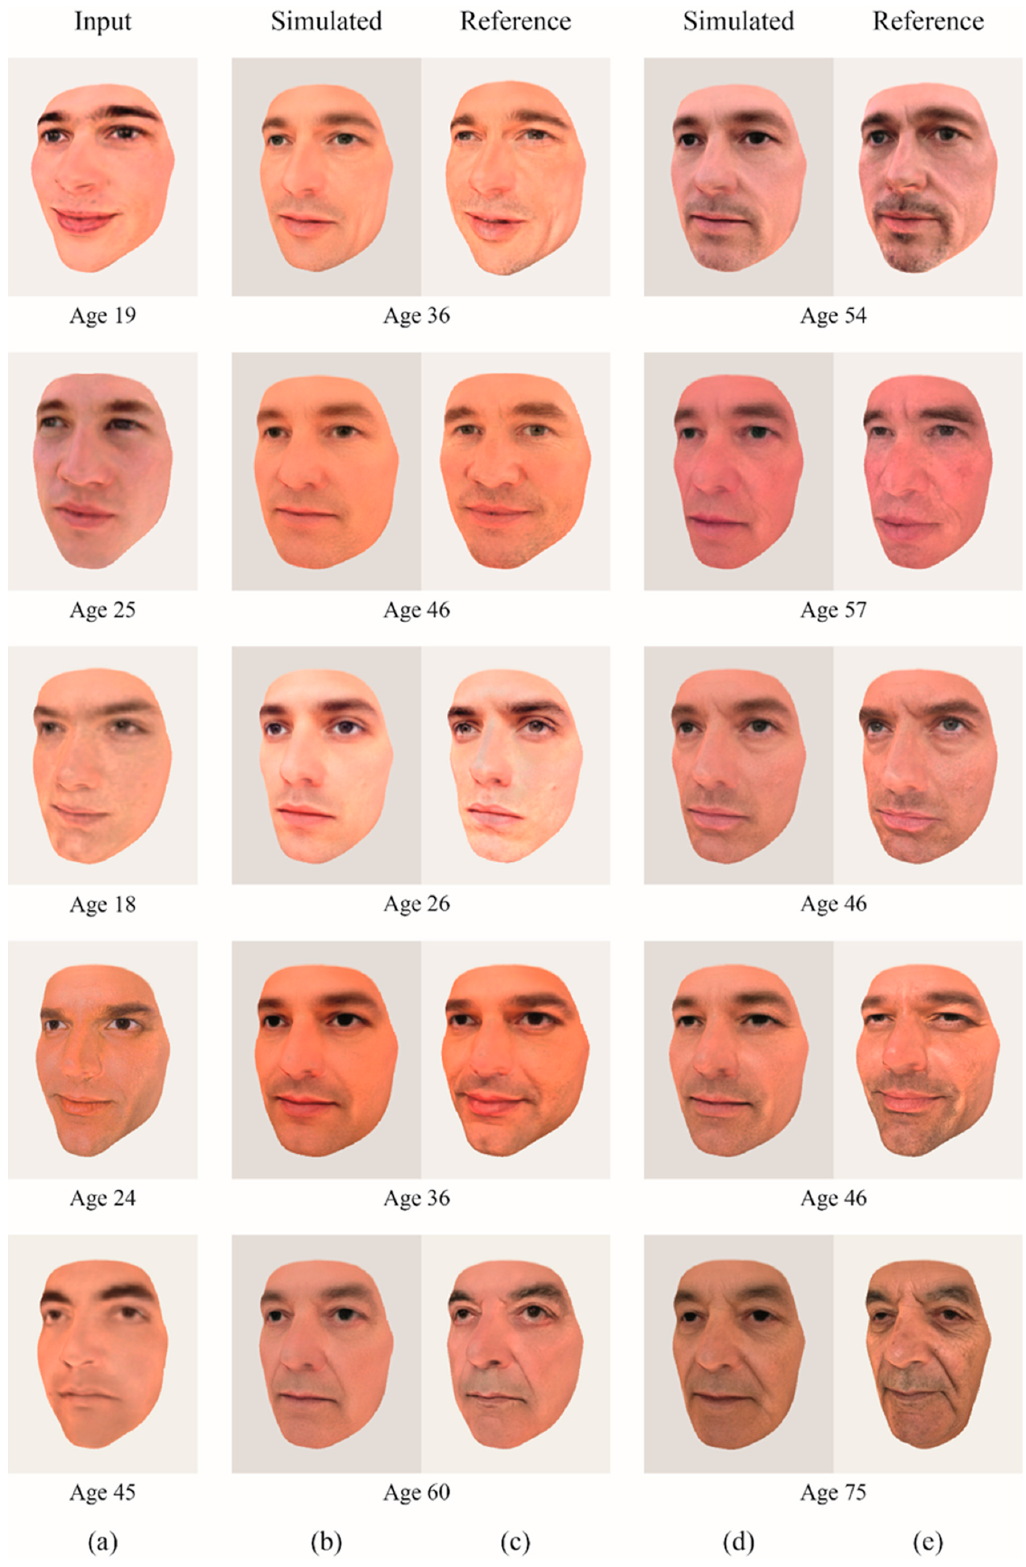
Figure 6. Male rendering results of applying the proposed 3D morphable face aging model (3D F-FAM). ( a ) Input textured mesh at actual age—adult; ( b , d ) output at target age— older; and ( c , e ) reference textured mesh at the same age as the output to apply in the evaluation mode.